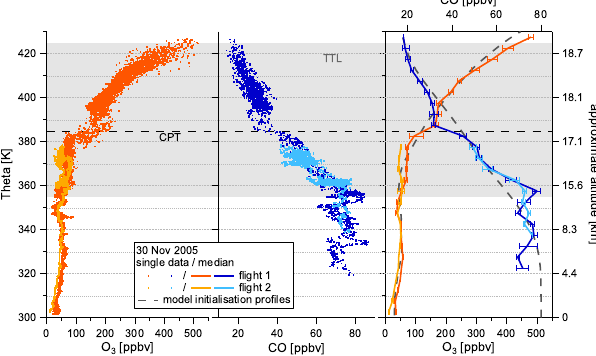
Figure 1. Observed ozone and carbon monoxide mixing ratio pro- files (left and middle panel) during the double flight on 30 Novem- ber 2005. On the right, the median observed profiles with the 33 and 67 percentiles (error bars) are shown together with the model initialisation profiles (see Sect. 5). The shading indicates the TTL as defined by Fueglistaler et al. (2009) and the dashed line indicates the cold point tropopause